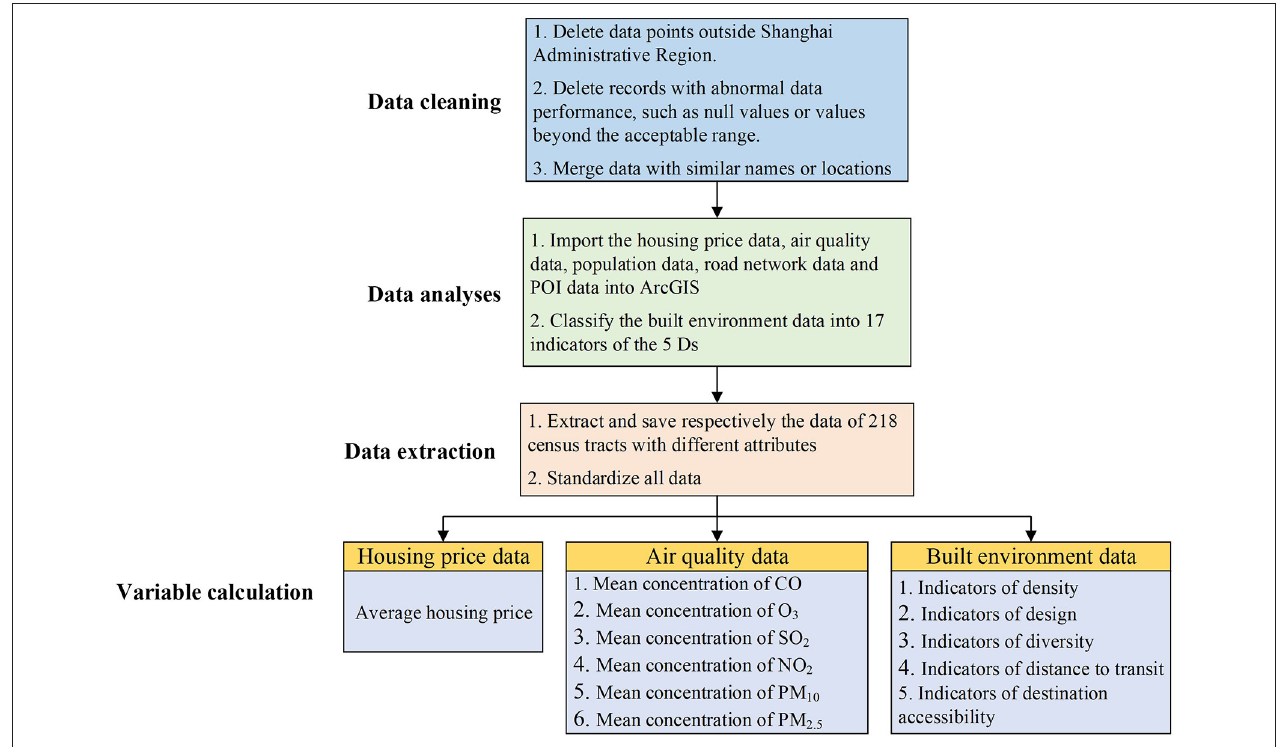
FIGURE 7 | Diagram of the data